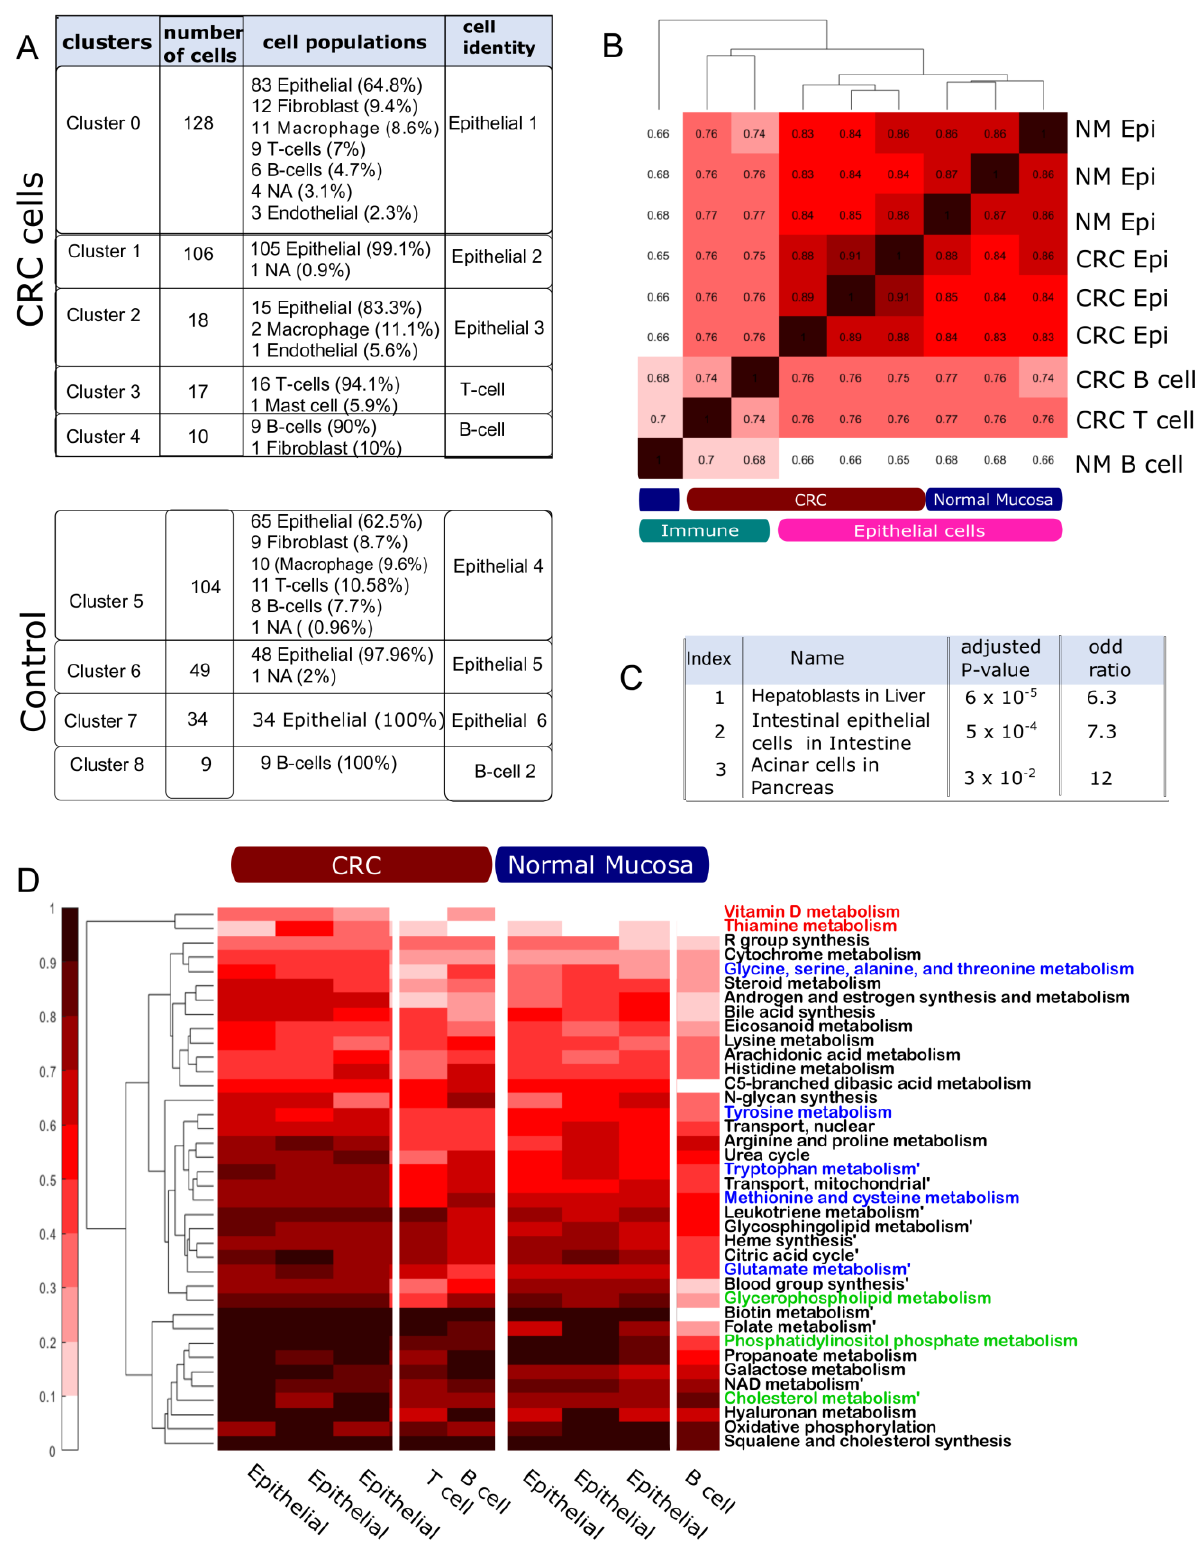
Figure 3. Pathway analysis: scFASTCORMICS captures metabolic variations between the cell populations for a colorectal cancer (CRC) example (Datasets 1 and 2): ( A ) Composition of the 5 cell clusters in Dataset